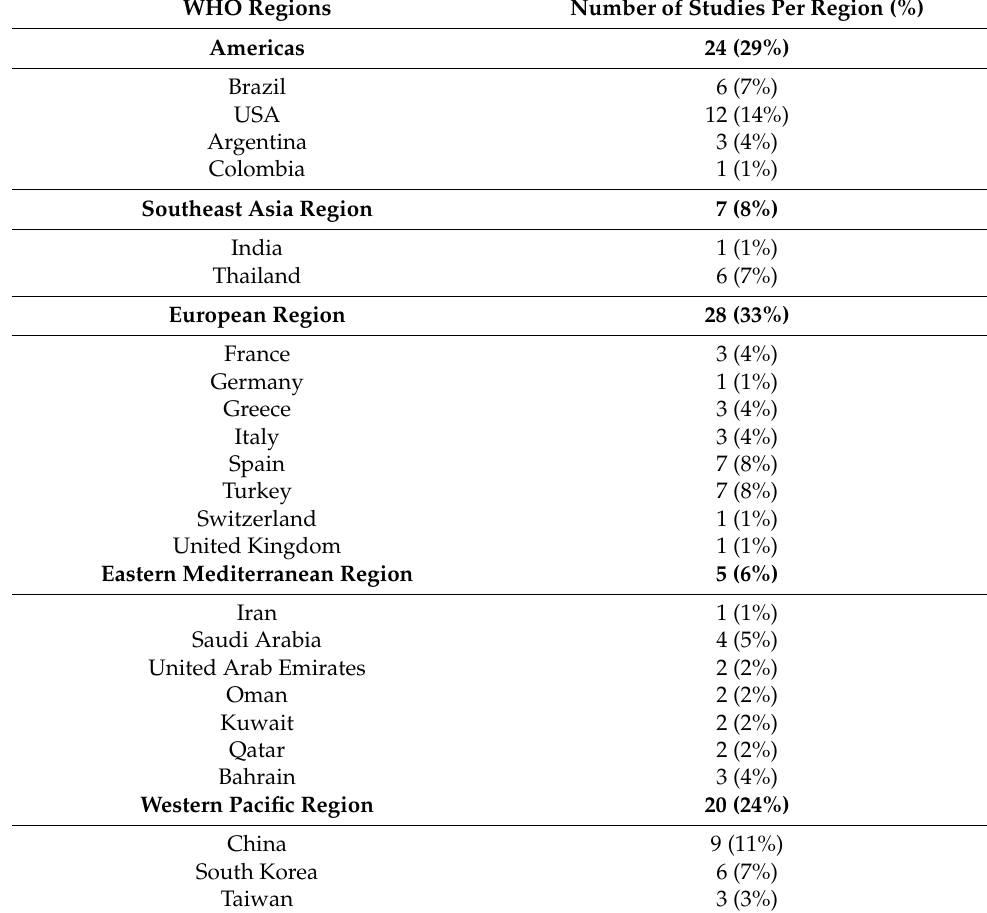
Table A2. Distribution of studies by country and WHO